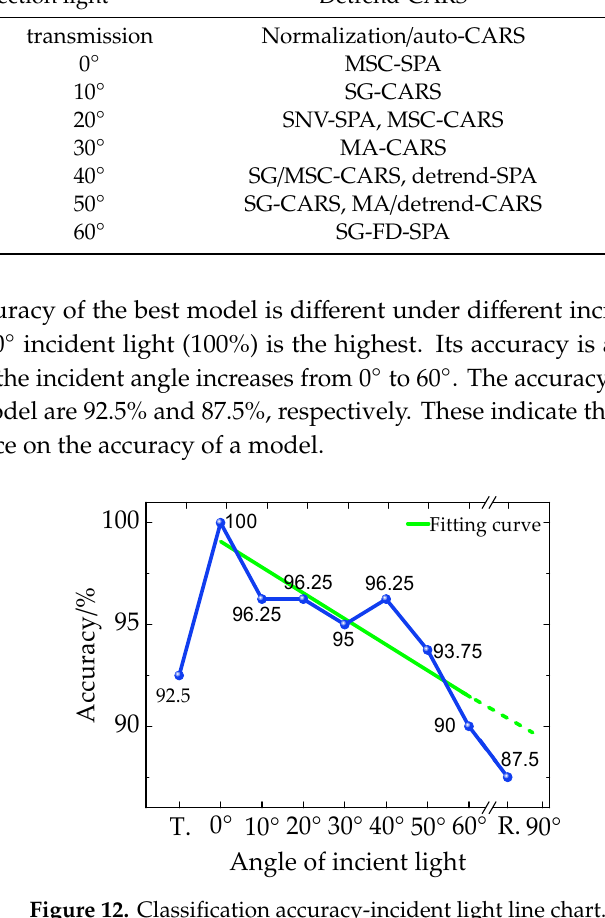
Figure 12. Classification accuracy-incident light line chart.